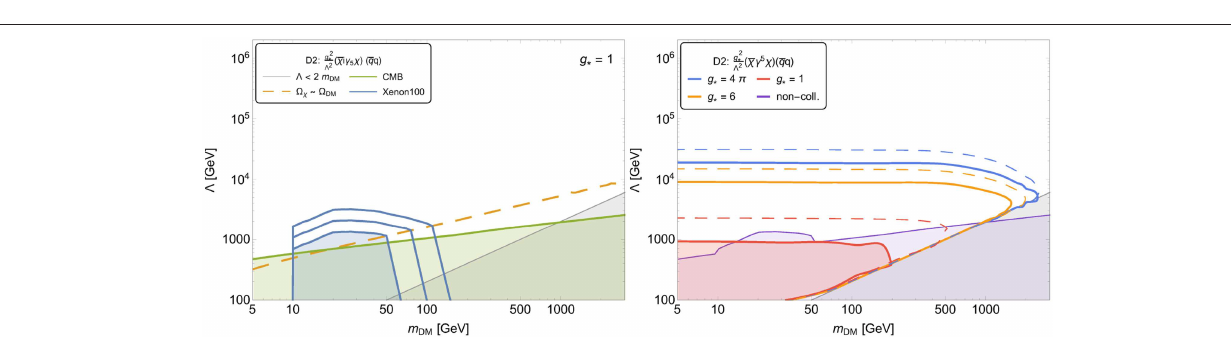
FIGURE 3 | (Left) Non-collider constraints on D2 operator with fermion DM: (i) SI DM DD searches (shaded blue region below the lowest blue contour), (ii) constraints from relic density (above the yellow dashed line), (iii) constraints from the CMB (shaded green area), and (iv) constraints from the validity of the EFT ( 3 > 2 m DM ). (Right) LHC monojet constraints on D2 EFT operator. The area inside the red, orange and blue solid curves is excluded by current LHC data at 95% CL for g ⋆ and 4 π , respectively. The projected LHC limits for 300 fb − 1 are indicated by dashed thin lines. The combined exclusion regions from CMB and DM DD searches for g ⋆ 1 are given by the light-purple area. See details and complete set of plots in Belyaev et al. [27]. =